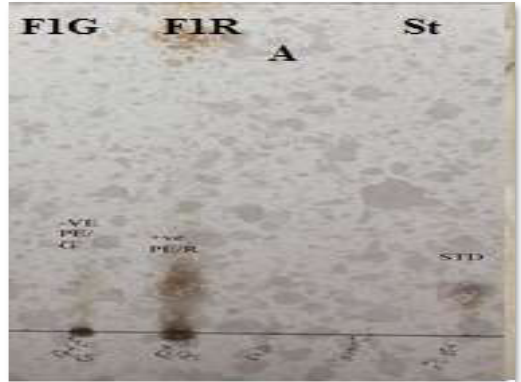
Figure 3.TLC chromatogram of pet. Ether / aerial parts and ß-sitosterol standard, analyzed using solvent system S1